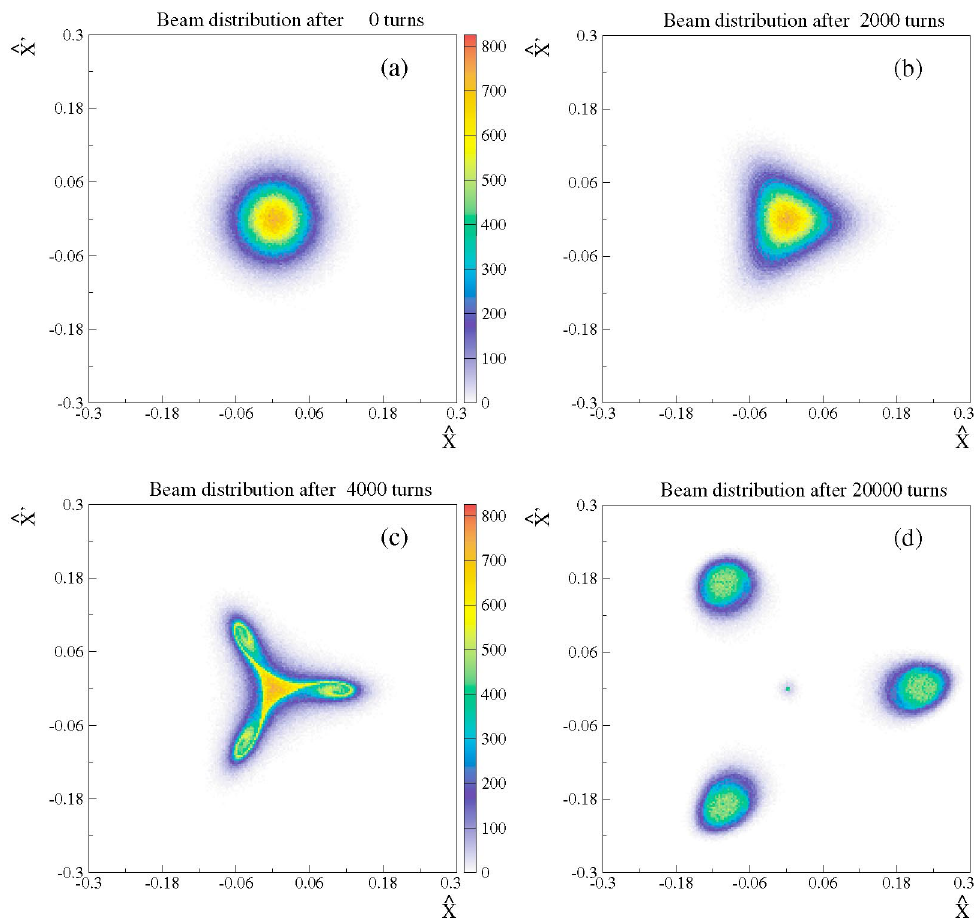
FIG. 4. (Color) Beam distribution during the trapping process with three islands ( 8 : 1 (cid:9) 10 5 initial conditions). The initial distribution is a Gaussian centered on zero, with standard deviation (cid:21) (cid:1) 0 : 04 , (cid:14) (cid:1) (cid:6) 5 . Even in this case very few particles are left in the central part of phase